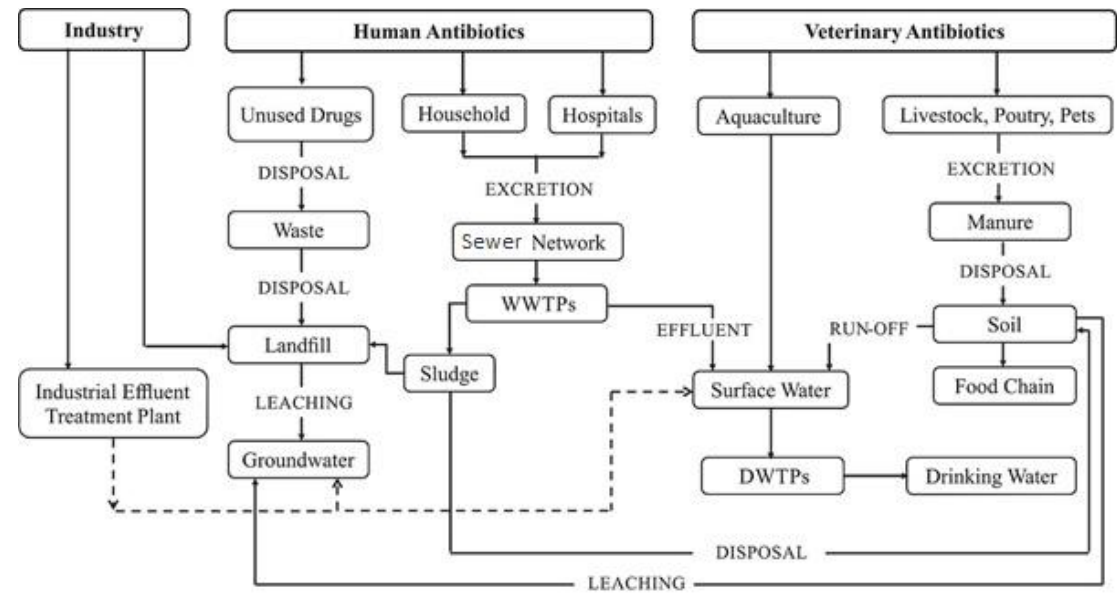
Figure 1: Pathways of antibiotics into the environment [44].